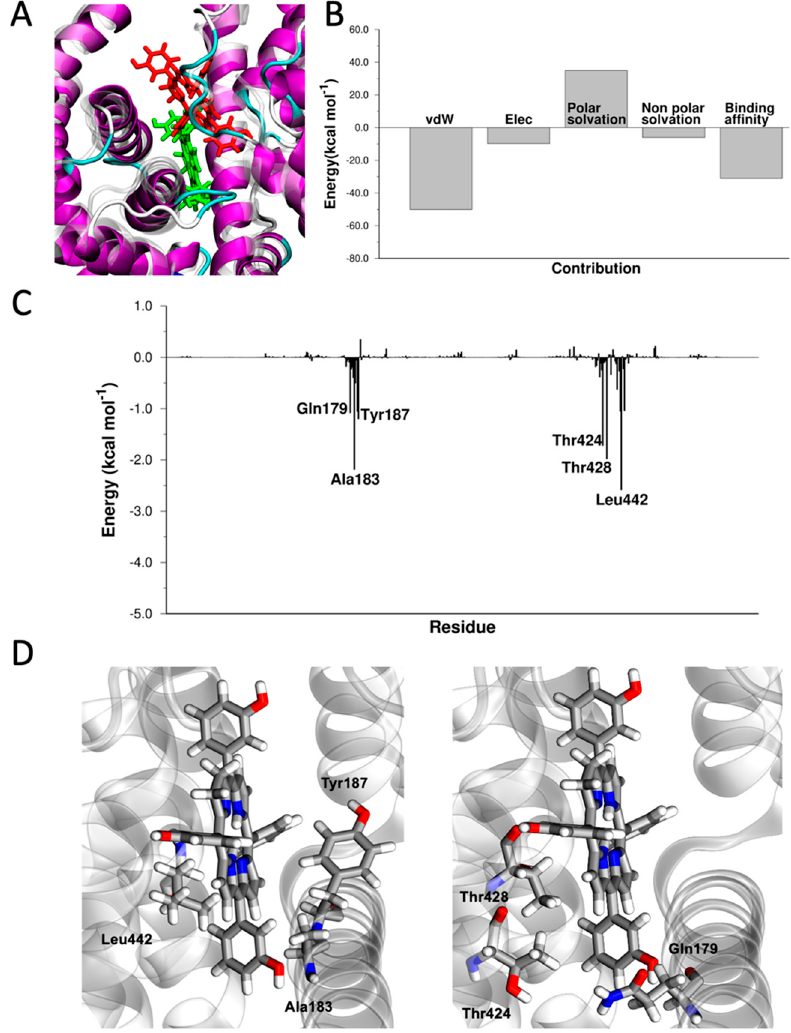
Figure 5. ( A ) Superposition of the docked structure of mTHPC in afamin (in green) and in HSA (in red). ( B ) Energy components of ∆ E binding . ( C ) ∆ E binding decomposed per residue. ( D ) Graphical representation of the interaction between Gln179, Ala183, Tyr187, Thr424, Thr428, Leu442, and mTHPC. Images created with VMD